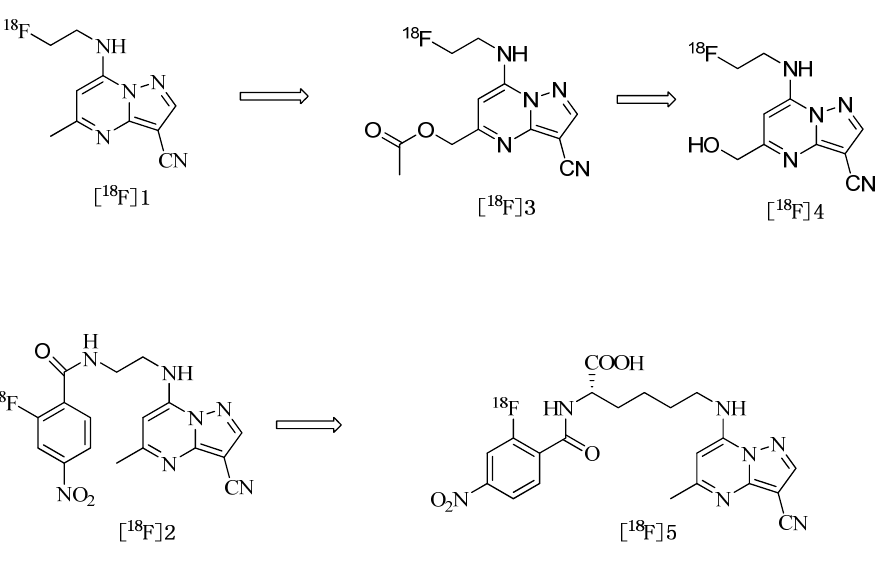
Figure 1. Structures of 18 F labeled pyrazolo[1,5-a]pyrimidine